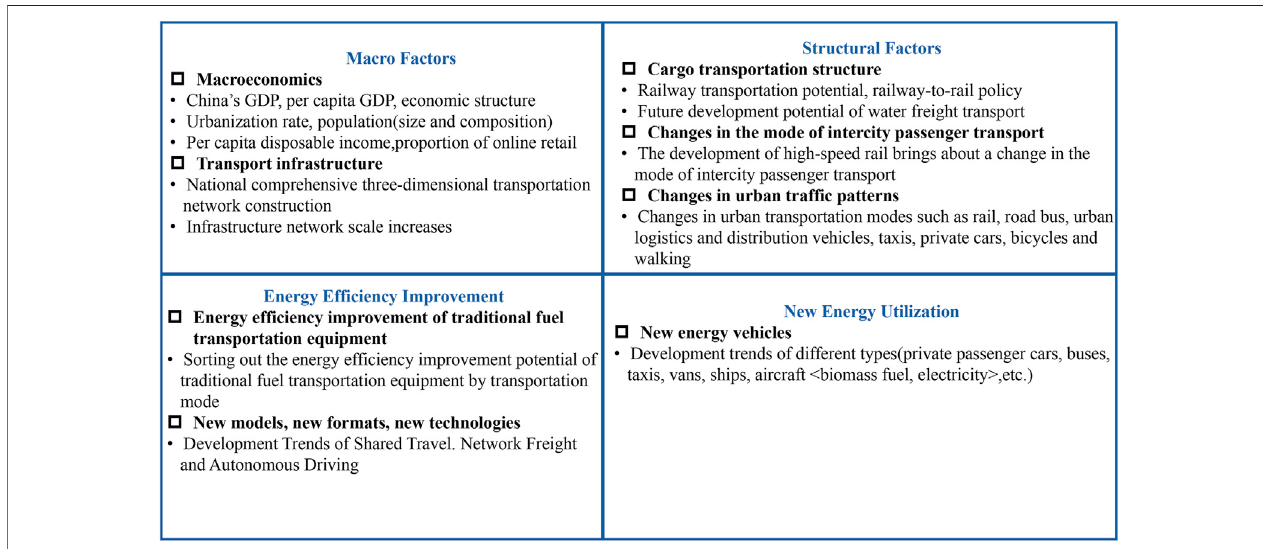
FIGURE 4 | The 13 factors affecting the transportation